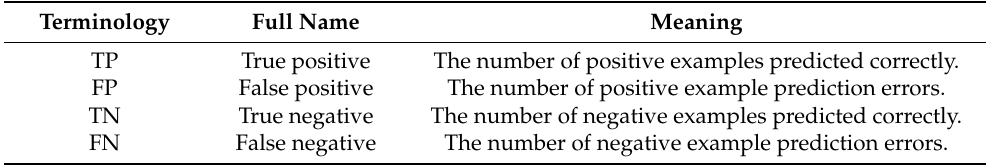
Table 1. The meanings of TP, FP, TN, and